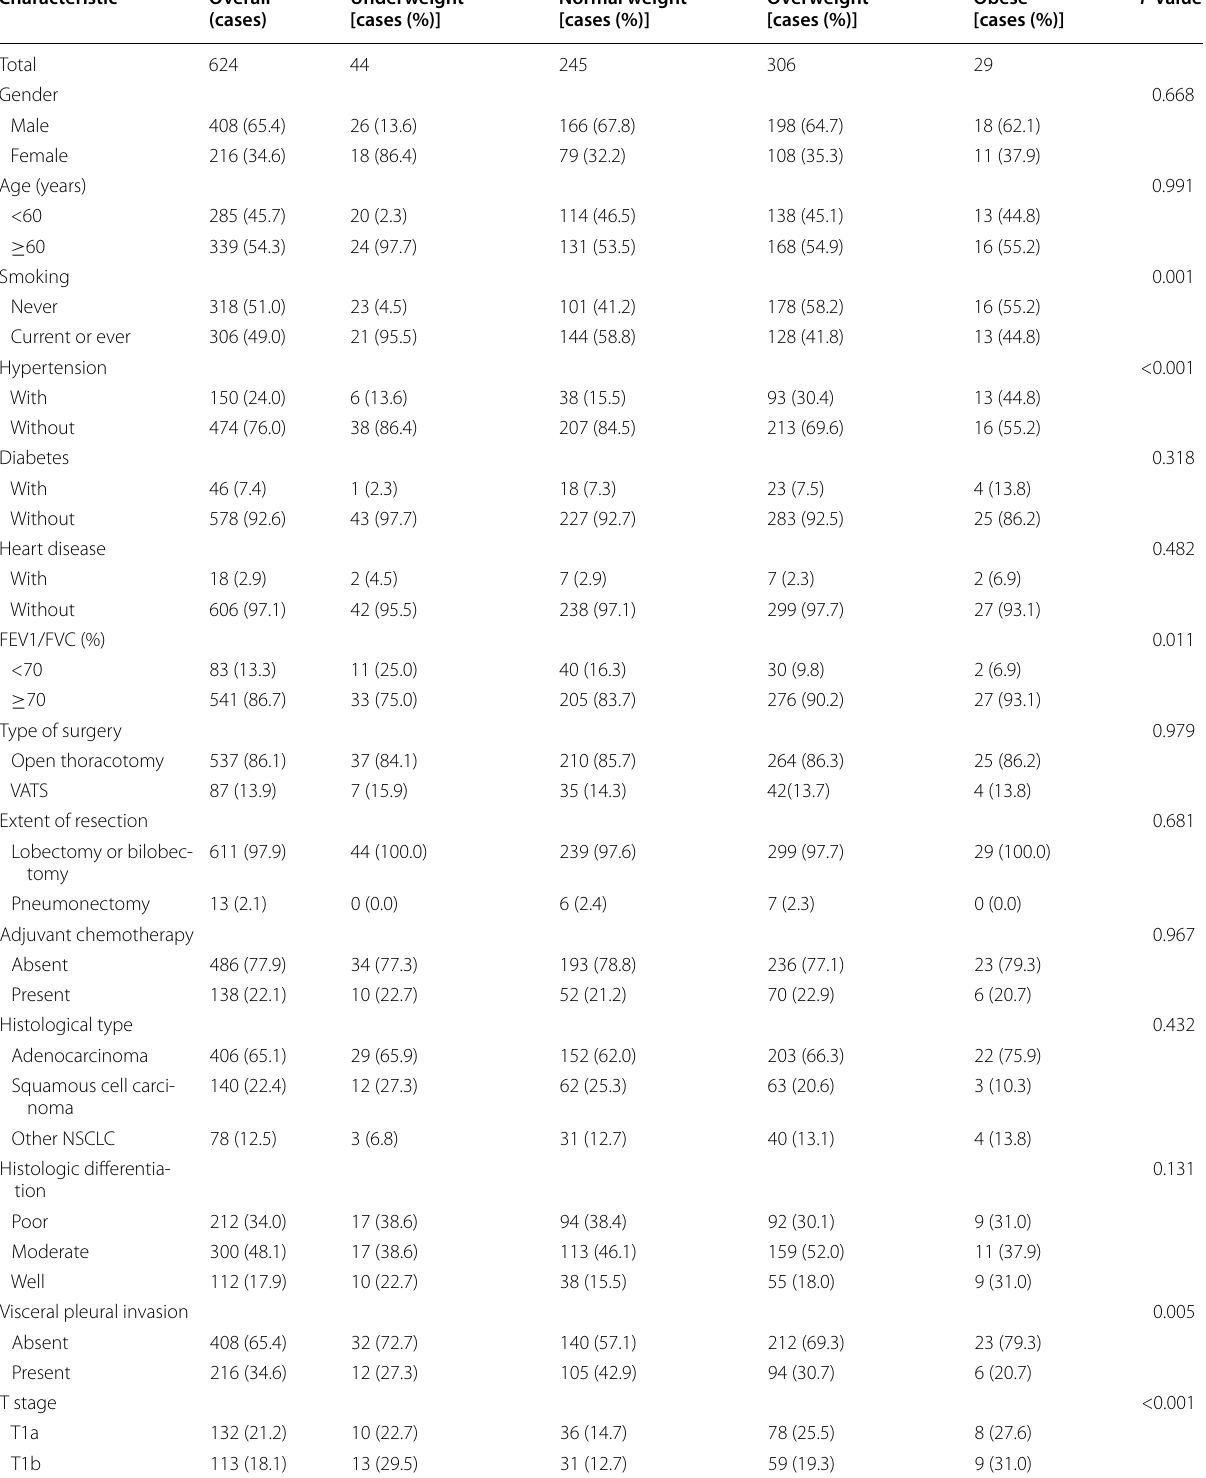
Table 1 The baseline clinicopathologic characteristics of underweight, normal weight, overweight, and obese patients with stage I NSCLC, stratified by